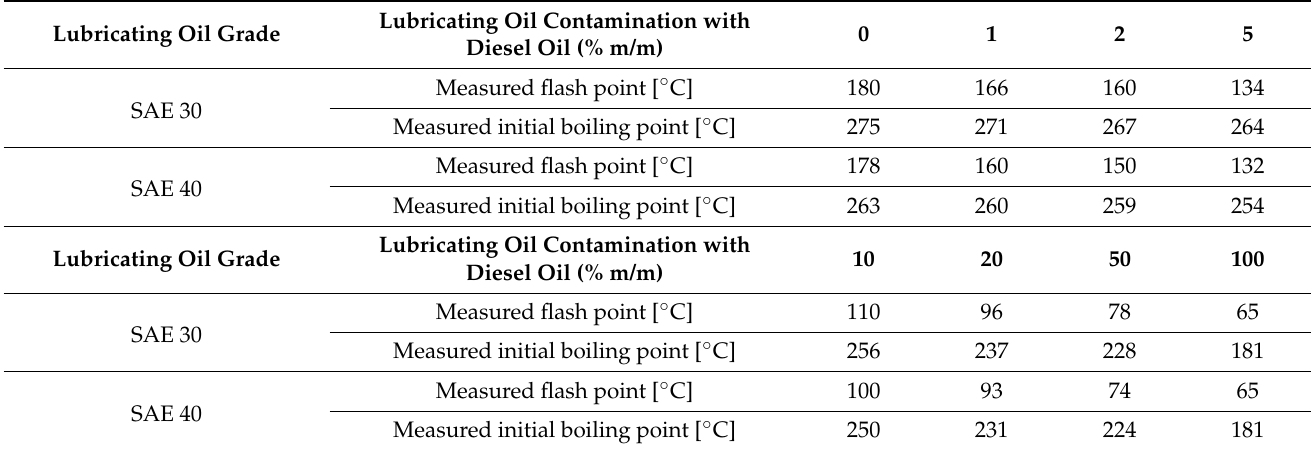
Table A3. Measured Flash Point and Initial Boiling Point